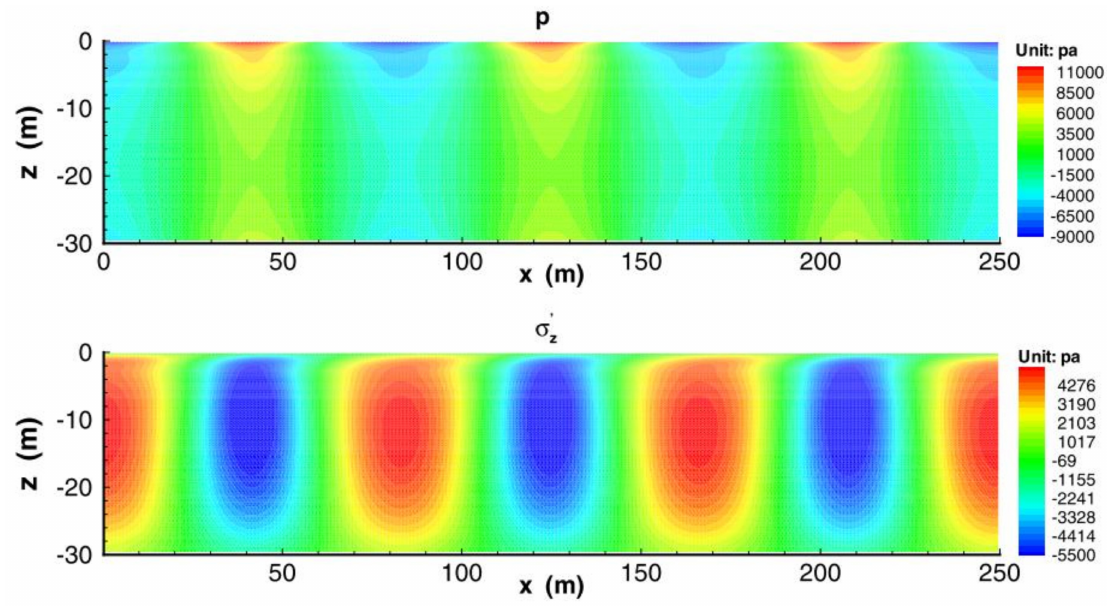
Figure 6. Seabed response to combined wave and current loading when v c = 1 m/s in Ye and Jeng [13].